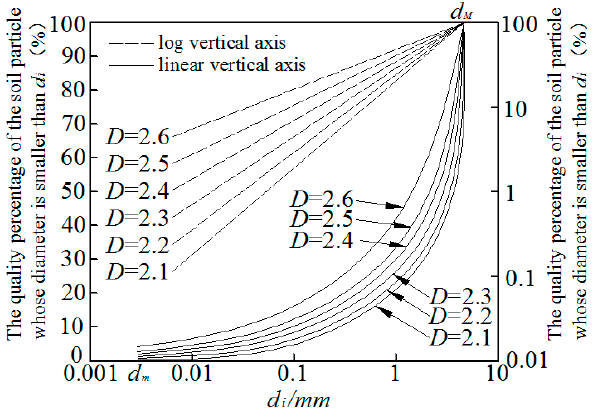
Figure 1. Particle size distribution curves defined by Equation (1).